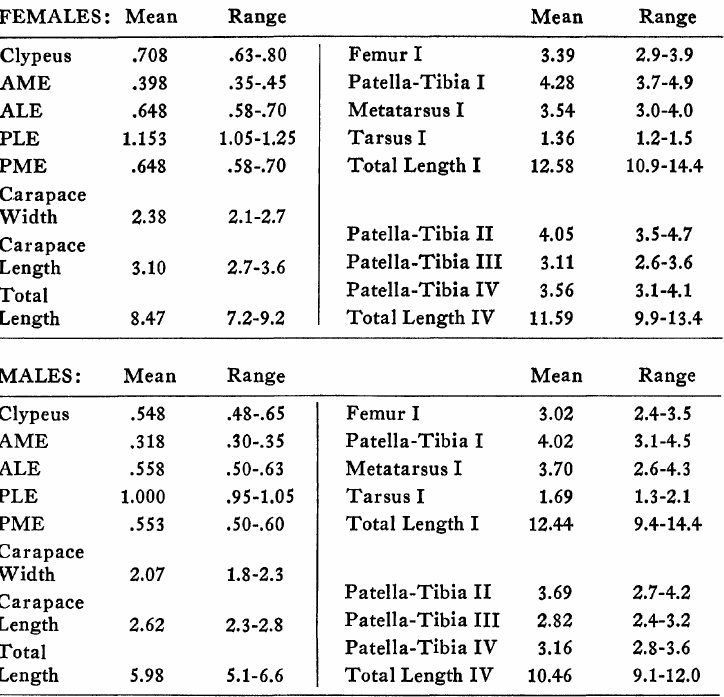
Color. Female. Face and chelicerae cream to yellow with thin black stripes rom AME to distal third o cheli.cerae as in Figure 3. Lighter col,or along lower edge o clypeus. Eye region overlaid with white appressed, spatulate-shaped hairs. Crapace cream to yellow with aint lines radiating ro.m thoracic groove as in Figure 4. Dorsum o abdomen white to pale yellow, with cardiac area trans- lucent. Mottled with darker colors along sides as in Figure t4. Venter with a broad median dark brown to black stripe rom epi- urrow o gastric spinnerets; median stripe outlined by to base white, becoming darker yellowish laterally. Legs cream to pale yellow. Labium and endites cream to yellow. Sternum cream to pale